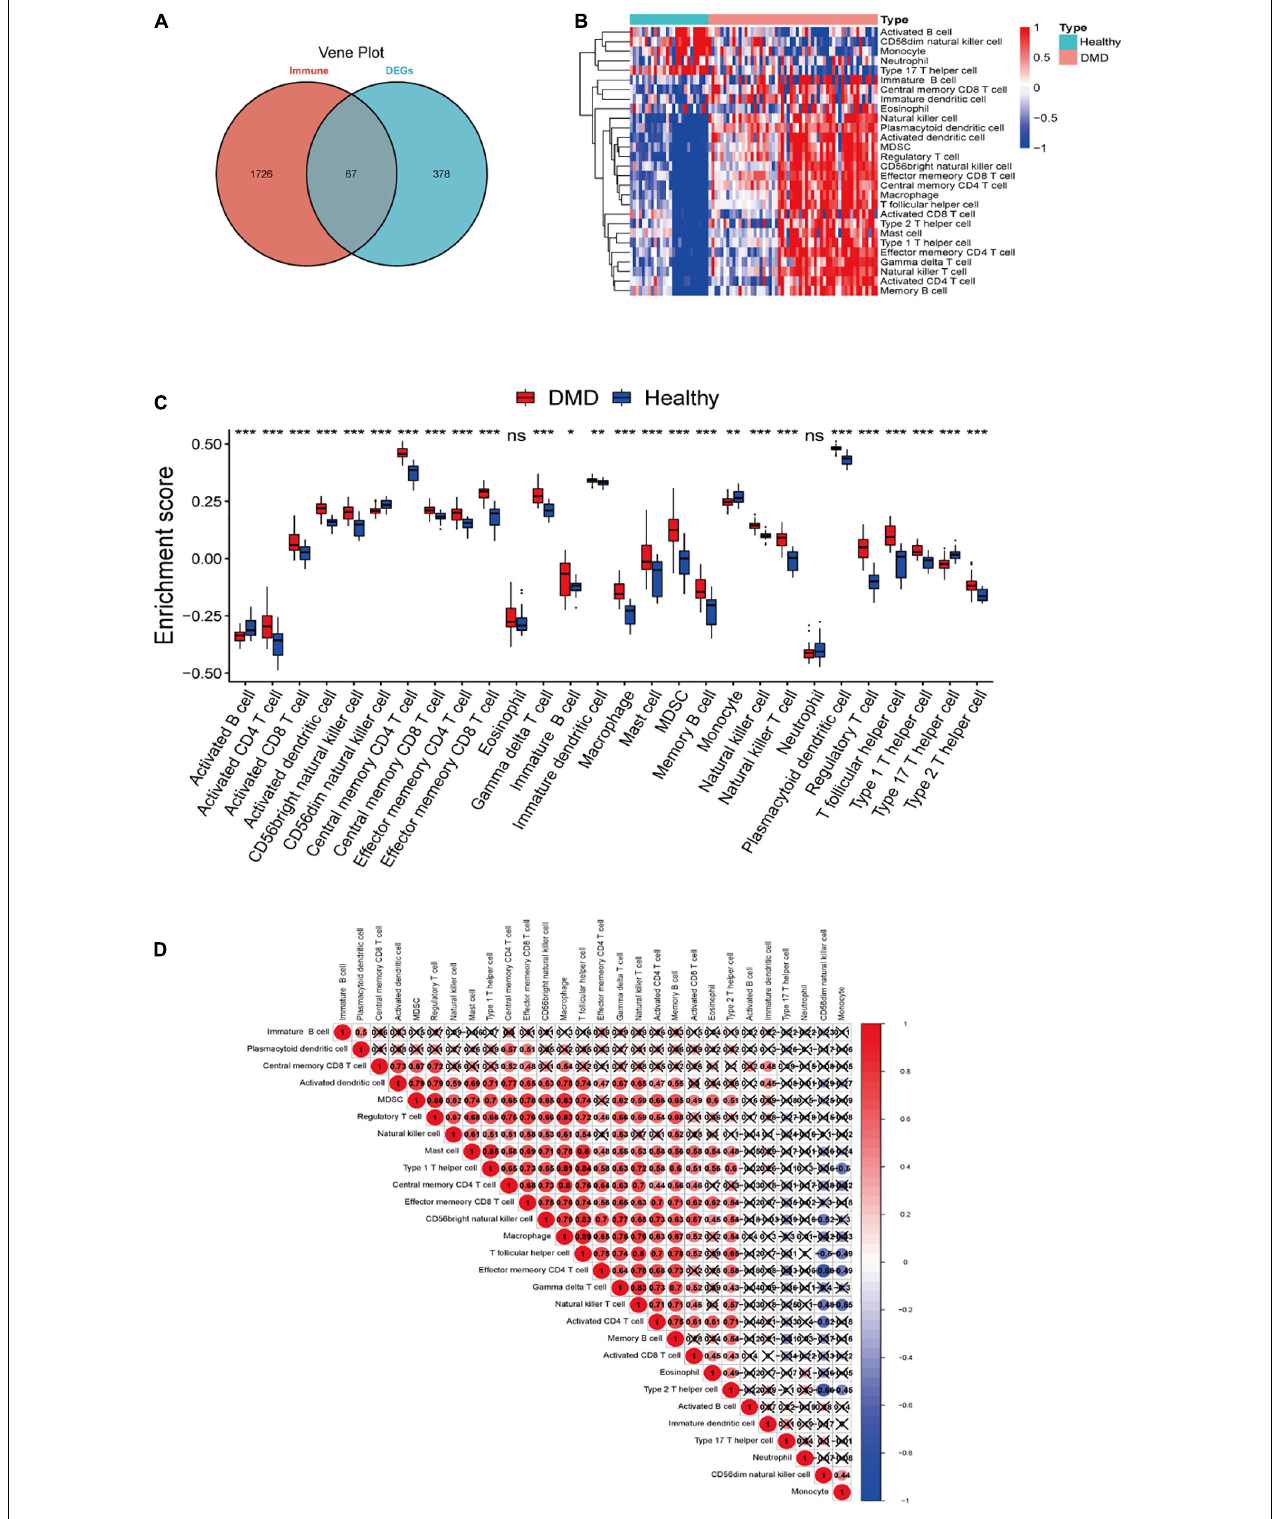
FIGURE 4 | (A) Venn diagram showing the identification of DEGs which were correlated with immune cells in DMD. (B) The overall landscape of immune cell infiltration in DMD ( n = 56 tissues). (C) Box plot showing the scores for 28 immune cells. (D) Correlations between 28 immune cells infiltrating in DMD muscle tissues (red for positive correlation, blue for negative correlation, white for weak or no correlation). ns, not significant; * P < 0.05; ** P < 0.01; *** P < 0.001.